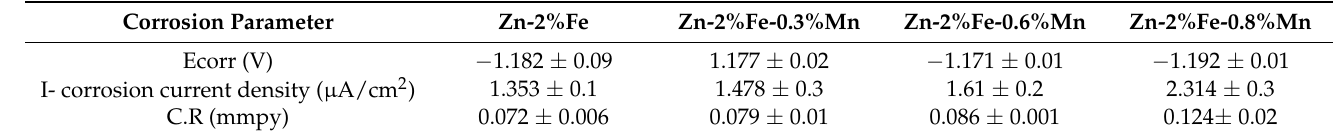
Figure 10. Potentiodynamic polarization curves of tested alloys as obtained in PBS solution. Table 4. Electrochemical parameters and corrosion rates by Tafel extrapolation generated from the potentiodynamic polarization analysis shown in Figure 10.